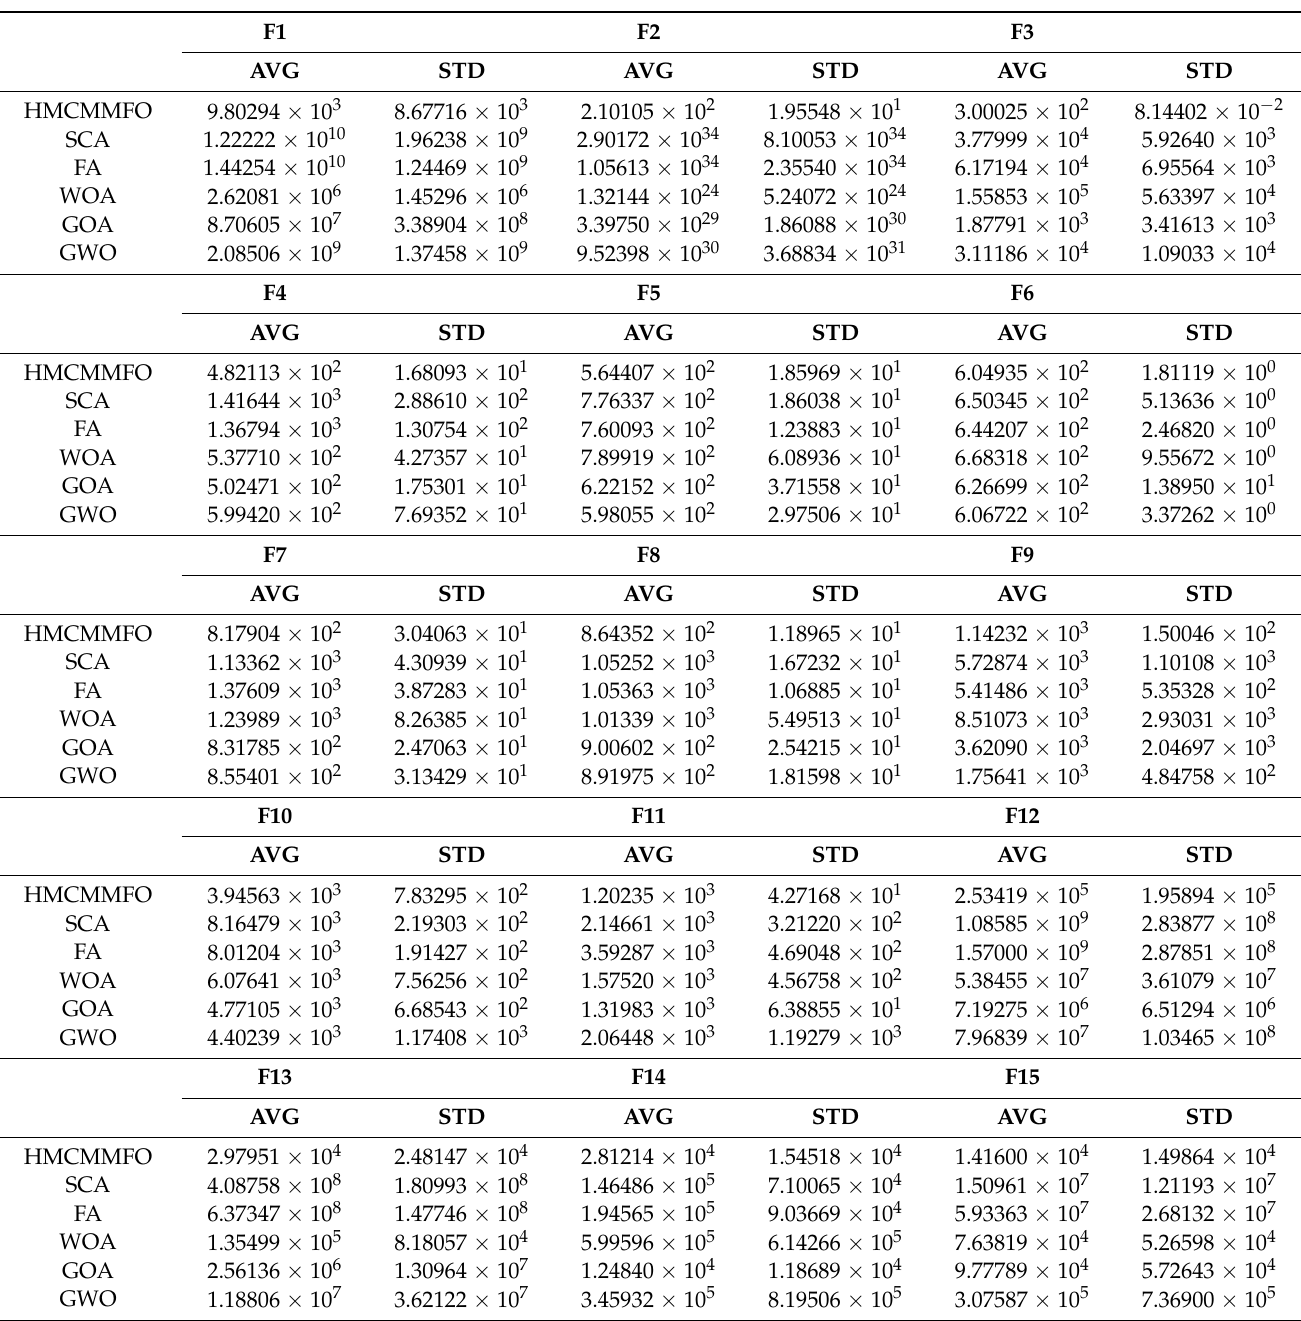
Table 7. Comparison of original